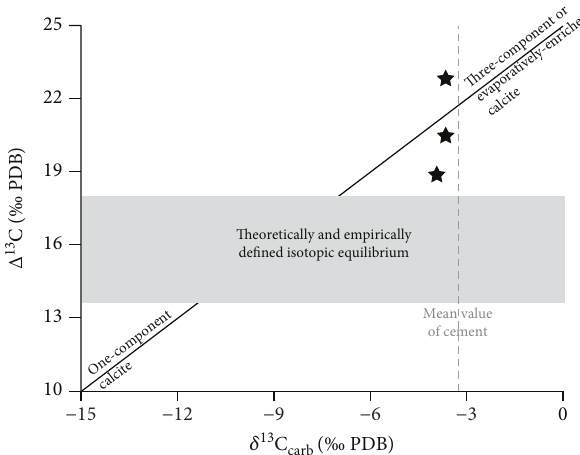
Figure 4: Individual soil pit δ 13 C depth pro fi les of fi ve Guvo Soil org and δ 13 C at depth Series soils. Di ff erences in surface δ 13 C Figure 6: Plot of δ 13 C versus Δ 13 C. The grey box spans Δ 13 C org org carb re fl ect di ff erences in the overlying vegetation, but each of the fi ve values +13.4 – 17.84 ‰ , which re fl ects the measured mean Δ 13 C pro fi les becomes asymptotic below ~ 20cm in the pro fi le, so value of +15.62 ‰ ± 2 σ (2.22 ‰ ). The solid black line re fl ects the δ 13 C values from pedogenic carbonates collected below those slope of all carbonates formed from one-, two-, and three- carb depths should be in isotopic equilibrium with their coexisting soil components of CO from Tabor et al. [6]. The data from Cotton 2 organic matter ’ s δ 13 C value. et al. [26] are given by black stars and represent either carbonates org formed under extremely evaporatively enriched conditions in terms of meteoric water or from three-component CO . In this 2 case, because the entire stratigraphic section is calcite-cemented (grey dashed line; δ 13 C = − 3.2 ± 0.2 ‰ ) and the calcite cement carb is isotopic indistinguishable from the pedogenic carbonates, one would conclude that the pedogenic carbonates re fl ect this inheritance or